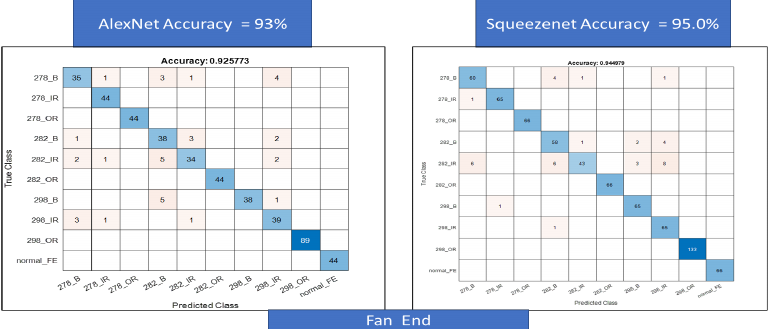
Figure 19. Figure showing confusion matrix using AlexNet and SqueezeNet for the fan end bear- ing